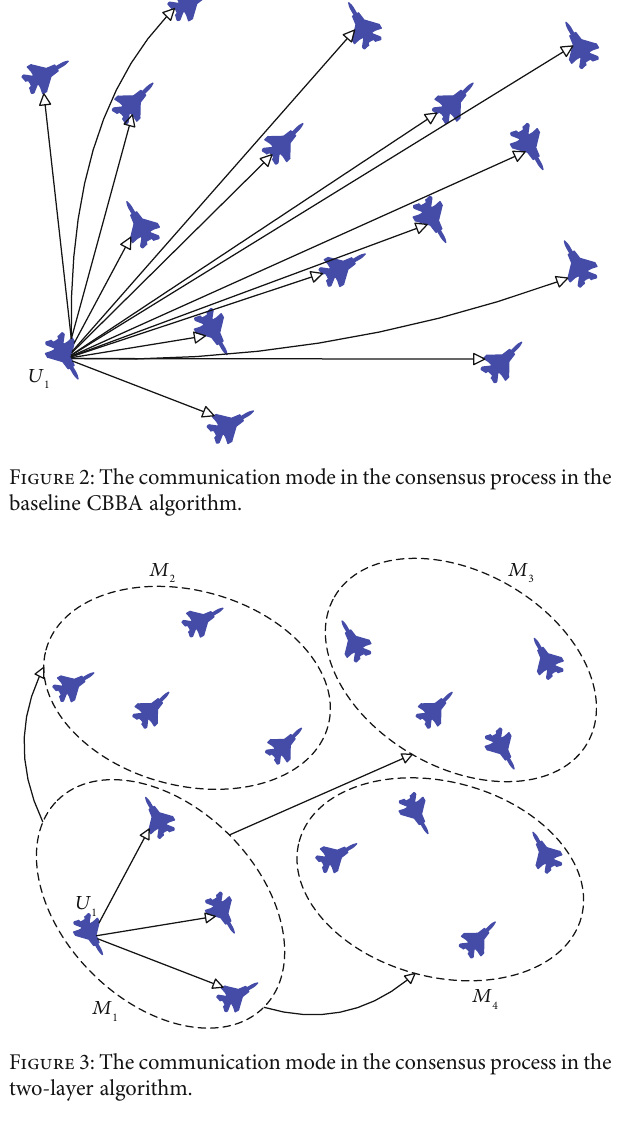
Table 3: The initial state of attack